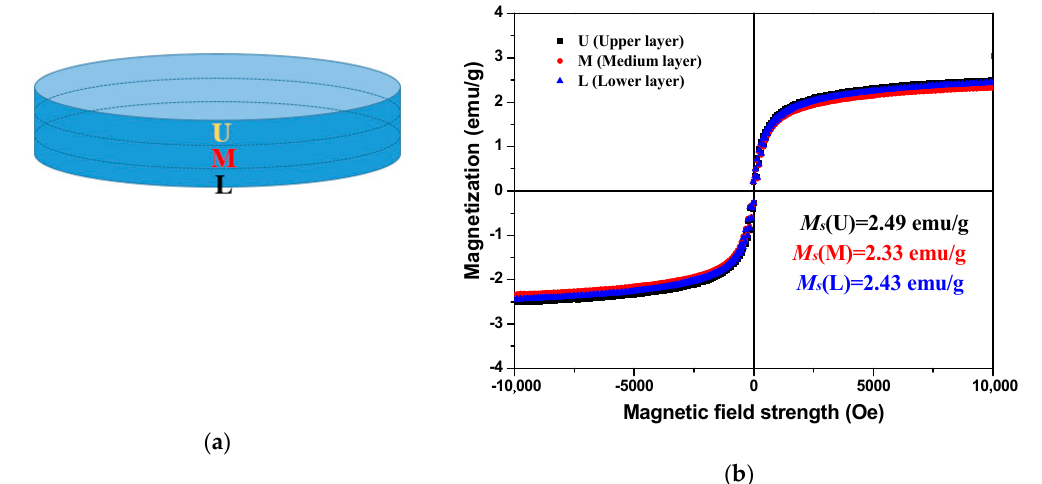
Figure 16. ( a ) Sample preparation and ( b ) magnetization curves of vibrating-sample magnetometer (VSM) measurement by vertically grinding into three layers.